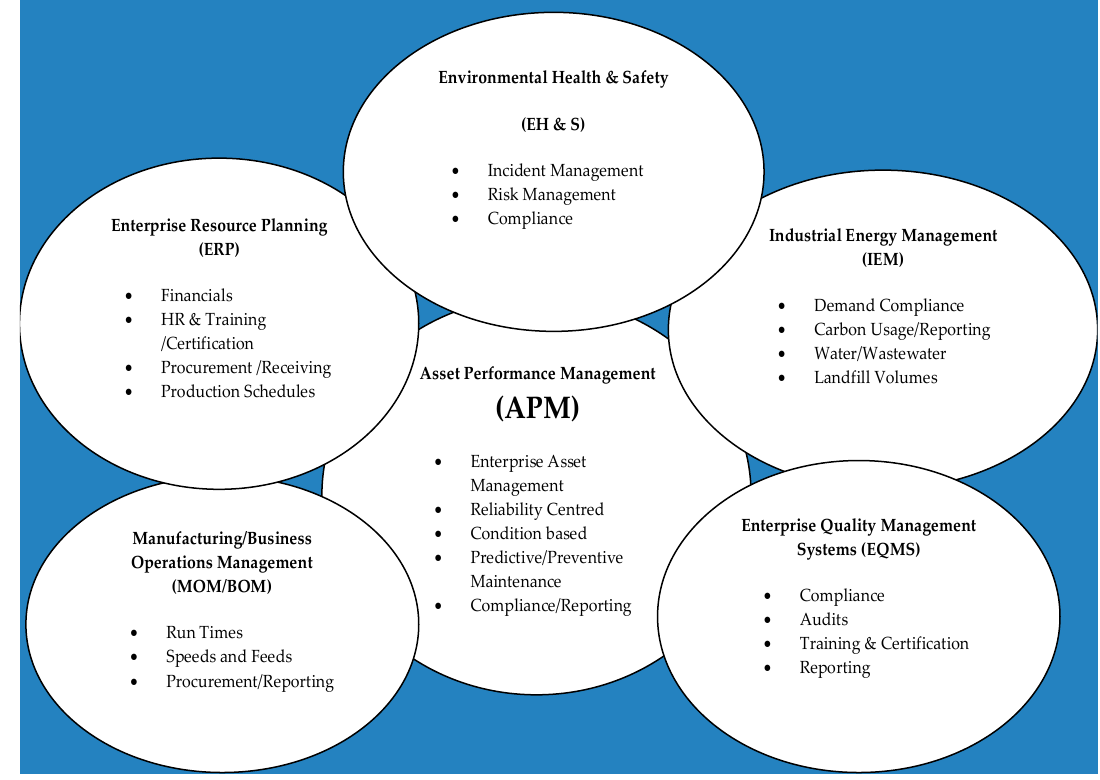
Figure 2. Asset Performance Management (APM). Source: [48].